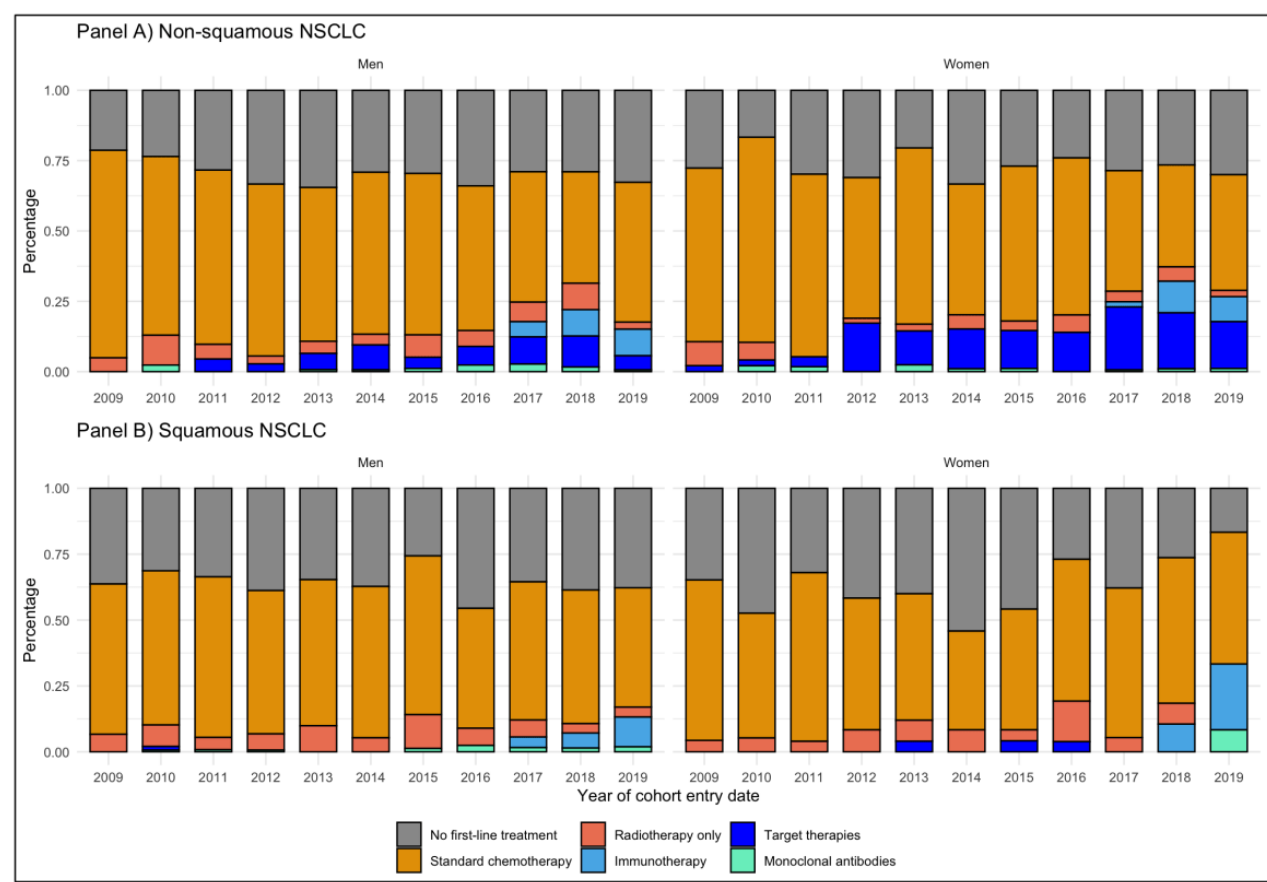
Figure 2. Distribution of first-line treatments per year of cohort entry: panel ( A ) non-squamous NSCLC; panel ( B ) squamous NSCLC.